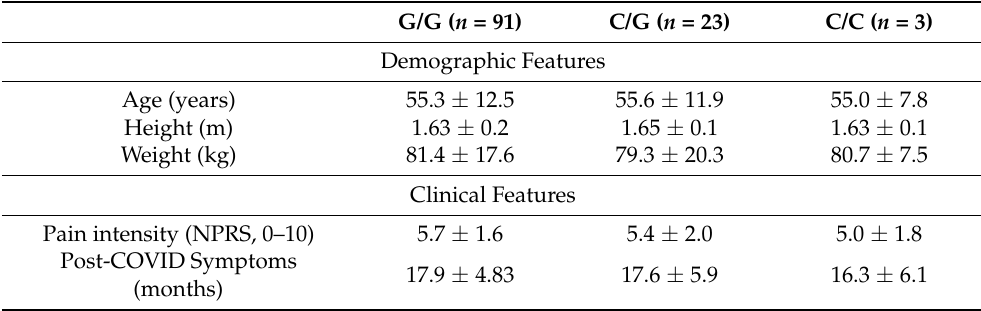
Table 2. Differences in pain phenotyping in COVID-19 survivors with post-COVID pain depending on the Interleukin-6 (IL-6) polymorphism